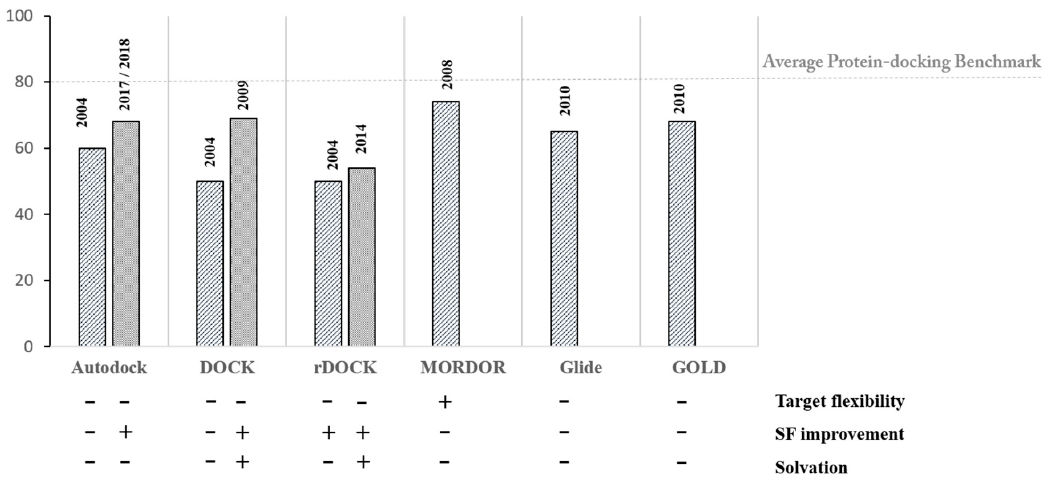
Figure 5. Benchmark comparison of some docking programs applied to or developed for nucleic acids. The average value of protein-docking benchmarks (80%), which has been retrieved from comparative assessments of published benchmarks [75–79], is used as indicator for comparison.